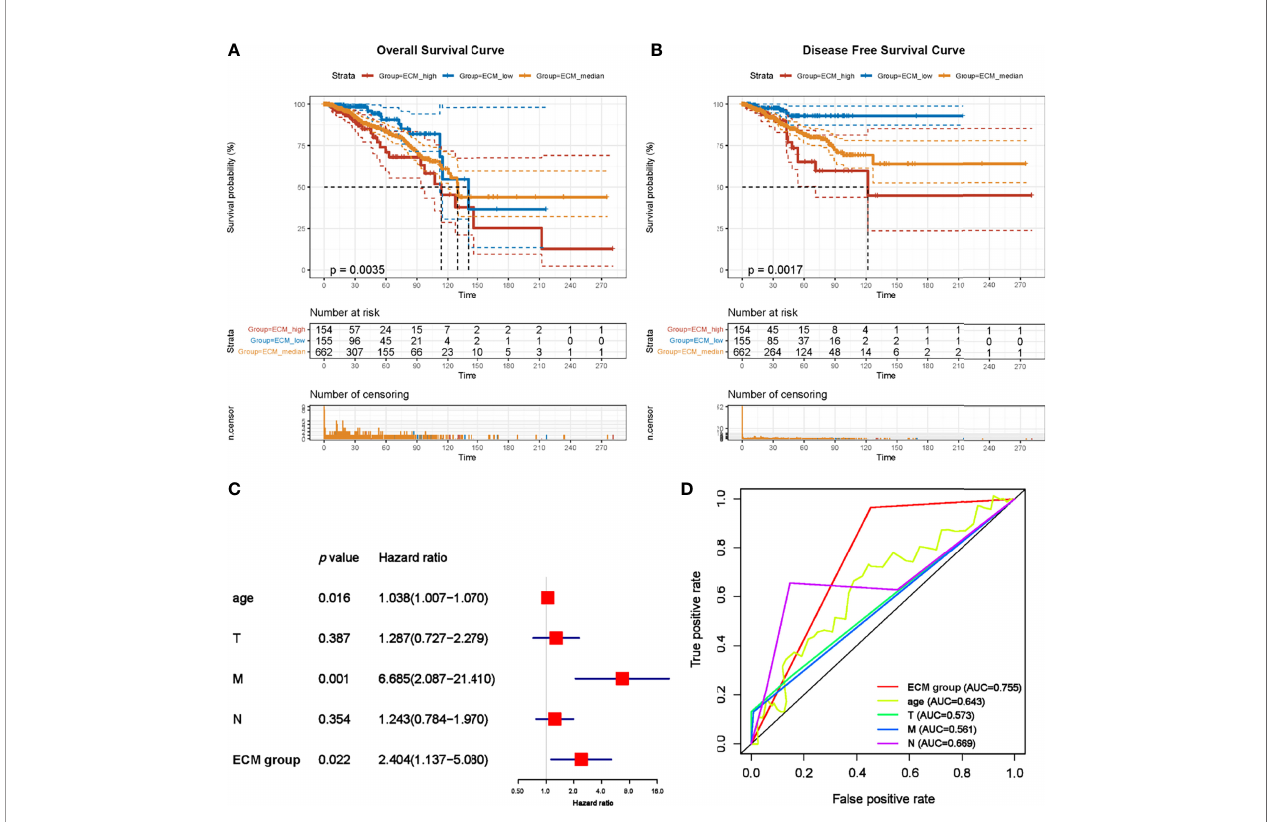
FIGURE 3 | C-ECM dysregulation is associated with the OS and DFS of breast cancer in TCGA database. (A) The Kaplan-Meier curves for the OS of patients in TCGA database which were divided into ECM-high, ECM-median and ECM-low group. (B) The Kaplan-Meier curves for the DFS of patients in TCGA cohort which were divided into ECM-high, ECM-median and ECM-low group. (C) Forest plots of Multivariate Cox regression analysis regarding OS in the TCGA database. (D) The AUC of time-dependent multivariate ROC curves was used to verify the prognostic performance of the ECM group in TCGA